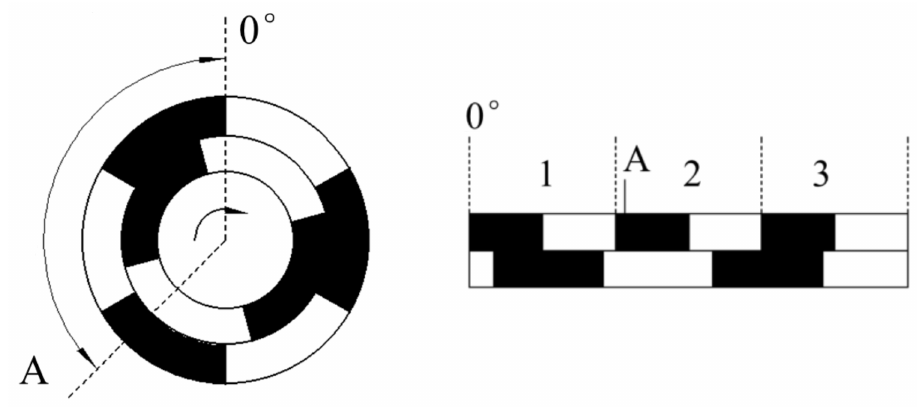
Figure 2. Simplified sketch of the magnetic